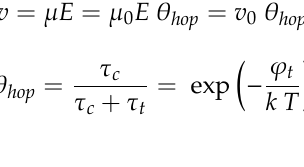
Figure 2. Energy level distribution and trap sites of epoxy resin before and after fluorination treatment.